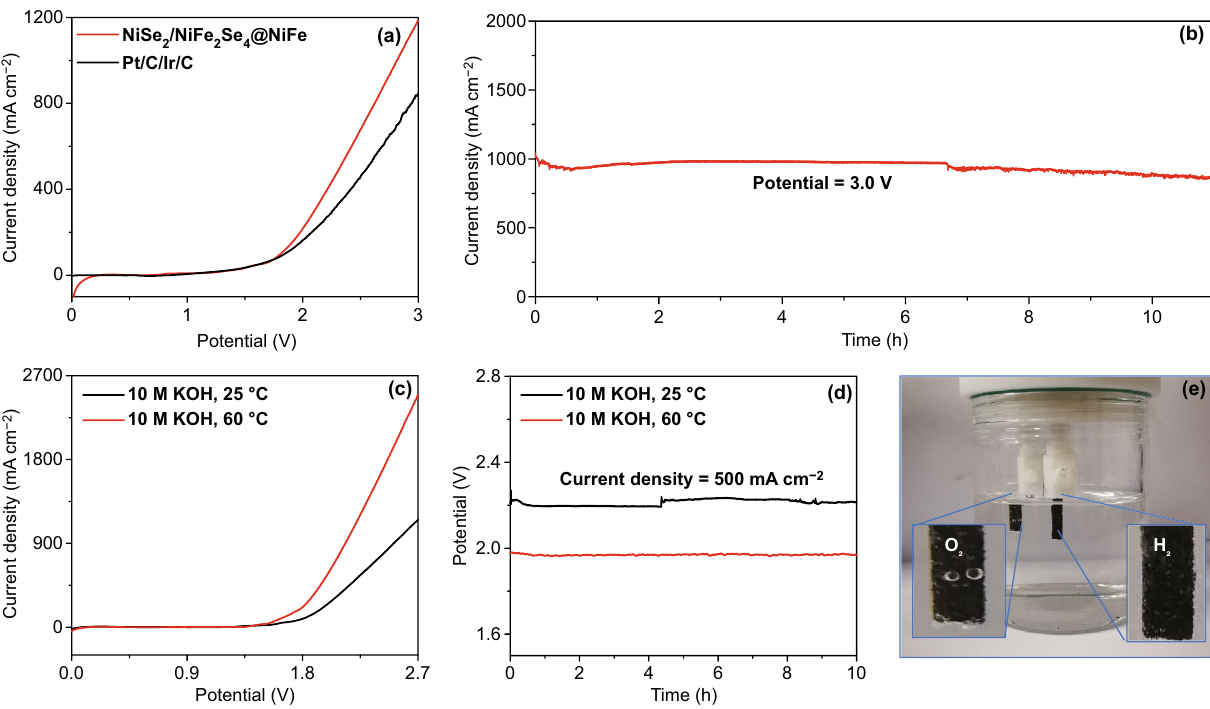
Fig. 5 a Polarization curves of bifunctional NiSe 2 /NiFe 2 Se 4 @NiFe and Pt/C-Ir/C for overall-water-splitting. b Chronoamperometric measure- ment at 3.0 V across NiSe 2 /NiFe 2 Se 4 @NiFe without iR compensation. c Polarization curves of bifunctional NiSe 2 /NiFe 2 Se 4 @NiFe for overall- water-splitting in 10.0 M KOH at 25 and 60 °C. d Chronopotentiometric curves with bifunctional NiSe 2 /NiFe 2 Se 4 @NiFe in 10.0 M KOH at 25 and 60 °C at 500 mA cm −2 without iR compensation. e Digital image of the generated H 2 and O 2 gas on NiSe 2 /NiFe 2 Se 4